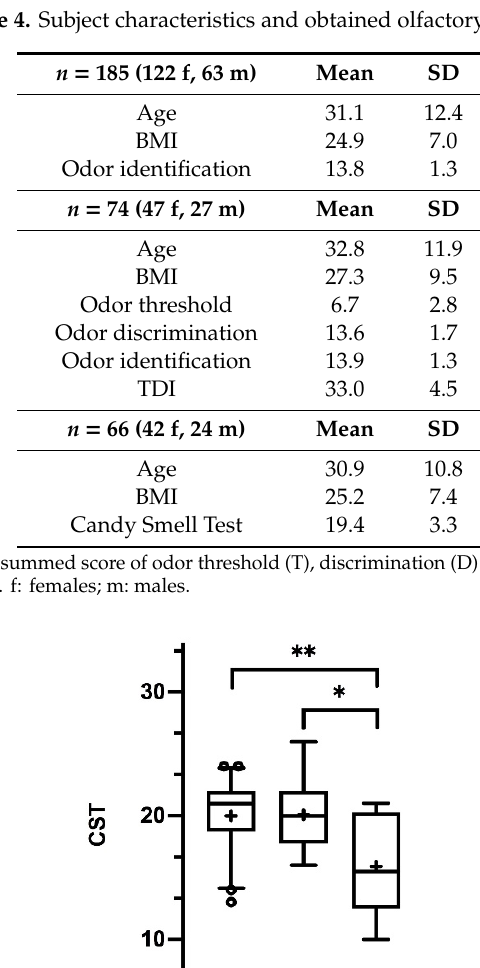
Table 5. Subject characteristics and questionnaire scores.